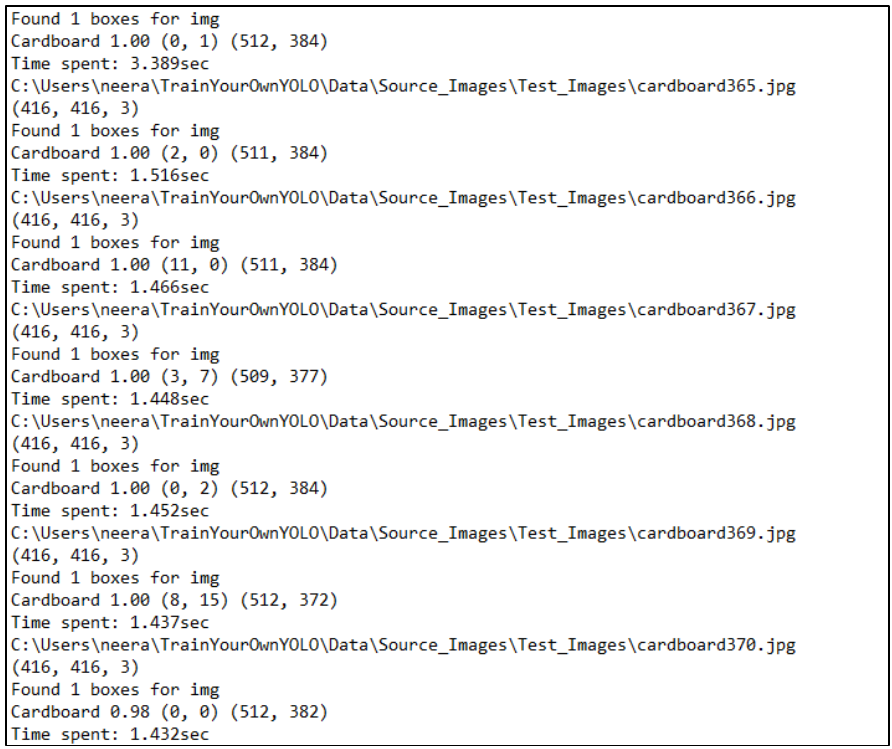
Figure 9. Image of Test folder